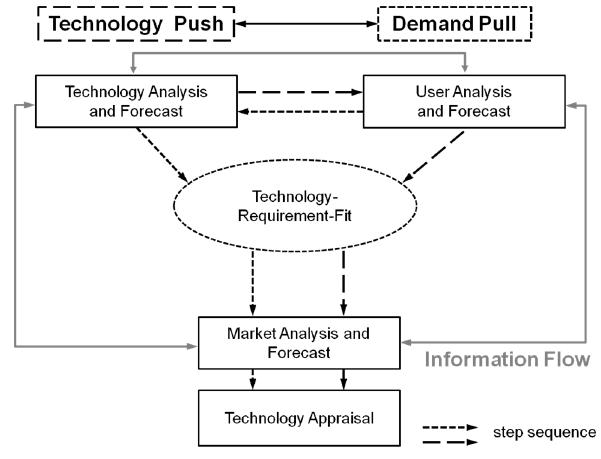
Figure 1. Basic structure of an integrated technology, user, and market analysis and forecast [4].